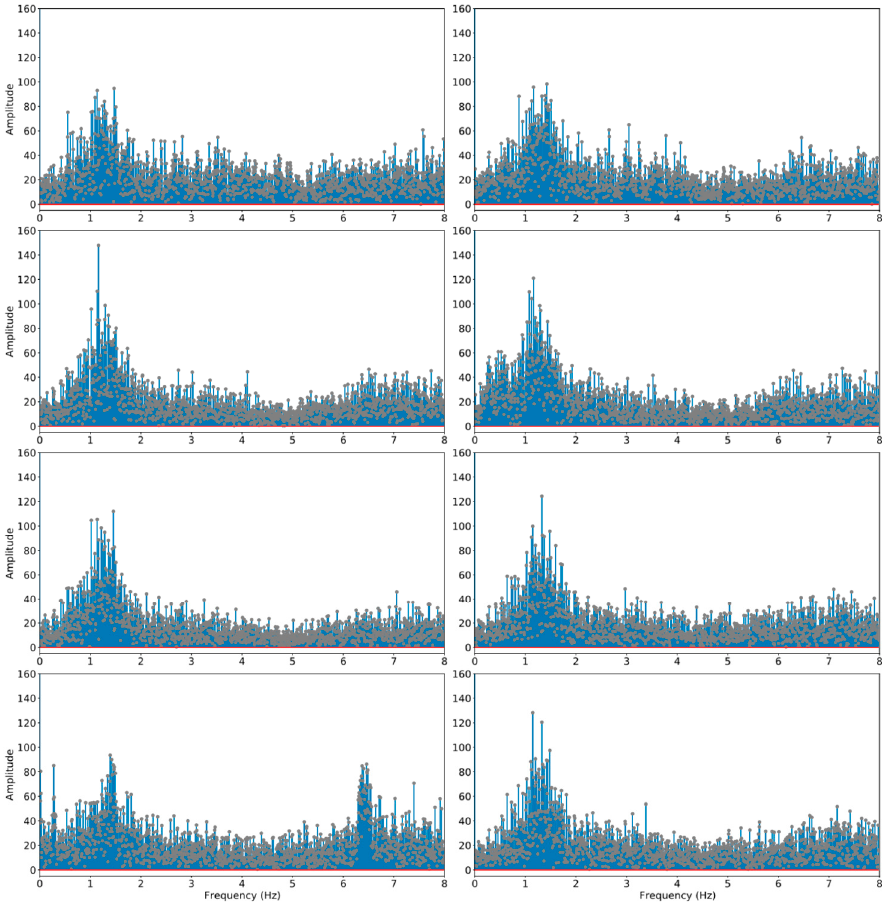
Figure 3. The PSD analysis of the eight independent test runs in one direction. The results from the PSD analysis revealed the predominant frequencies from the raw data. The stem plots show that the predominant frequencies are clustered around the frequency band (1–2) Hz, which are the typical frequencies generated by most cars’ suspension systems. Additionally, there are smaller clusters and relatively flat predominant frequencies across the x-axis; this is due mainly to the vibrations generated by the car engines and dashboards.